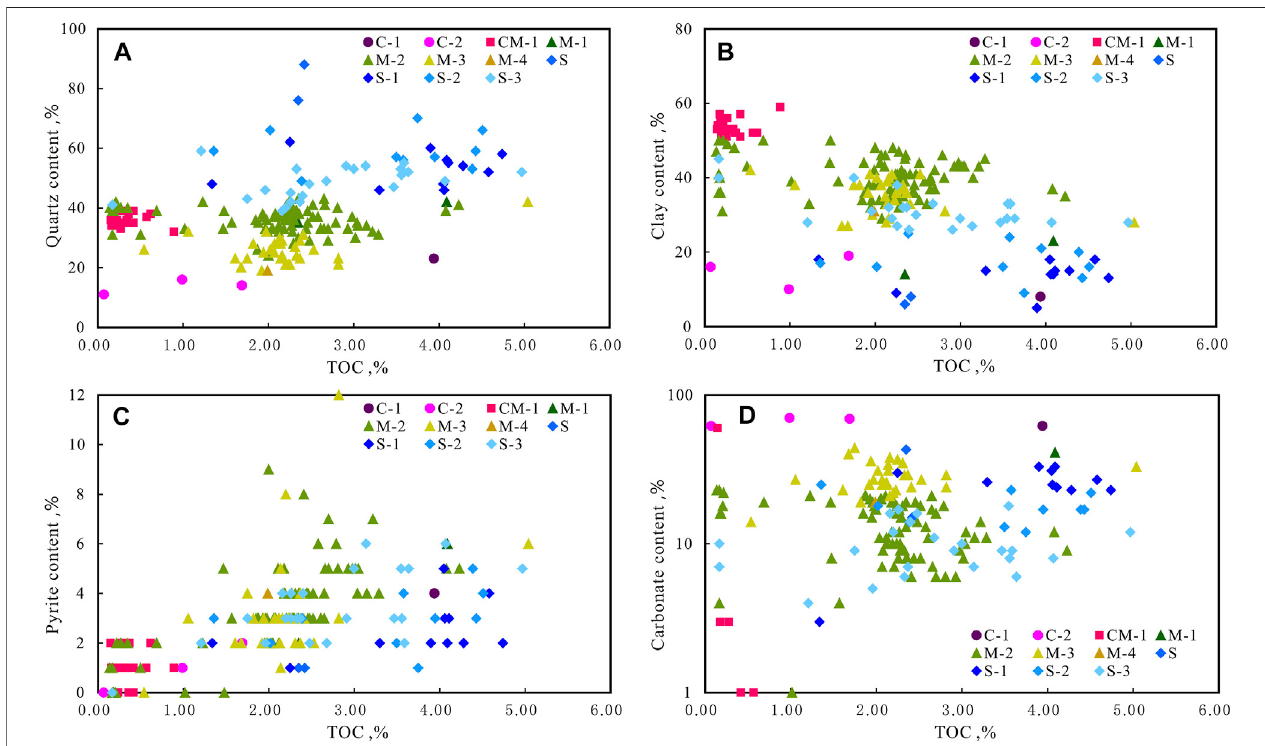
FIGURE6| TOCversusquartzcontent (A) ,claycontent (B) ,pyritecontent (C) ,andcarbonatecontent (D) oftheshalesamplesfromWufeng – LongmaxiFormation in the L203 well area.